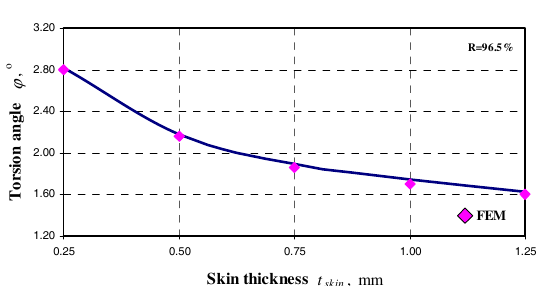
Fig 16. Finite element verification of response surfaces